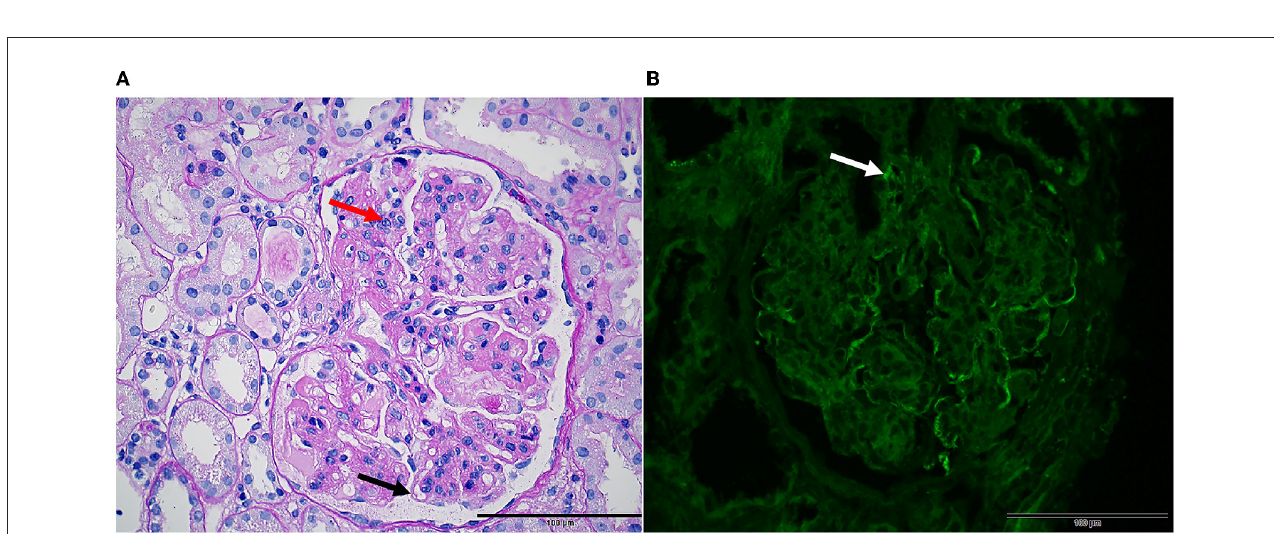
FIGURE2 Renal pathology in mixed cryoglobulinemia. Light microscopy ( × 10). (A) PAS stain shows membranoproliferative glomerulonephritis characterized by nodular lobulated changes in glomeruli, segmentally thickened and double-contoured appearance of the glomerular basement membrane (black arrow), diffuse intracapillary cell accumulation, and inflammatory cell infiltration (red arrow). (B) Immunofluorescence studies showing Immunoglobulin G deposit in vascular loops with line-like (white